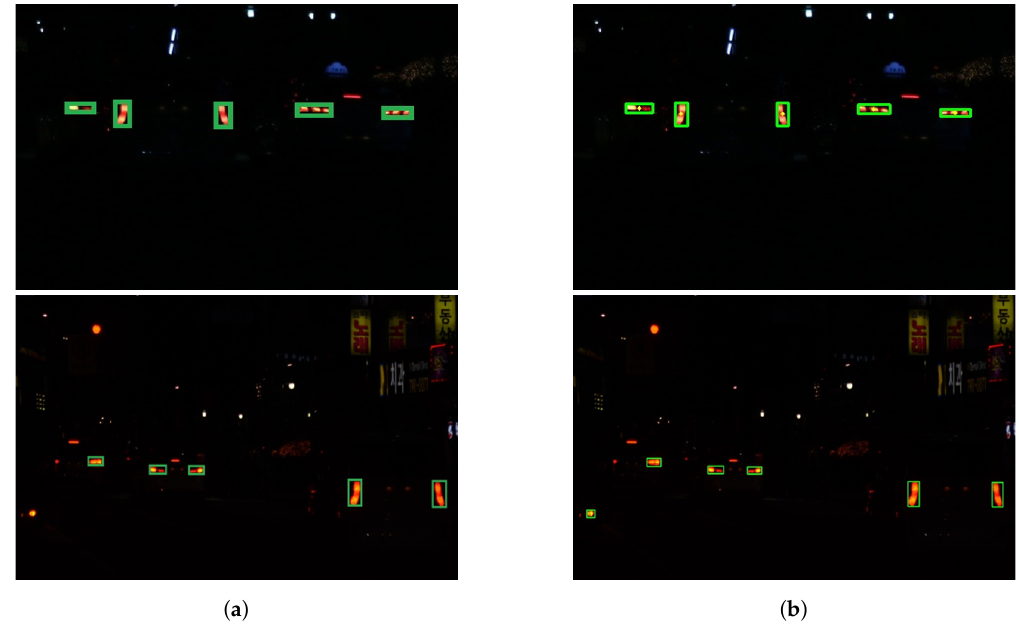
Figure 25. Some test samples for taillight detection: ( a ) detection result; ( b ) ground truth